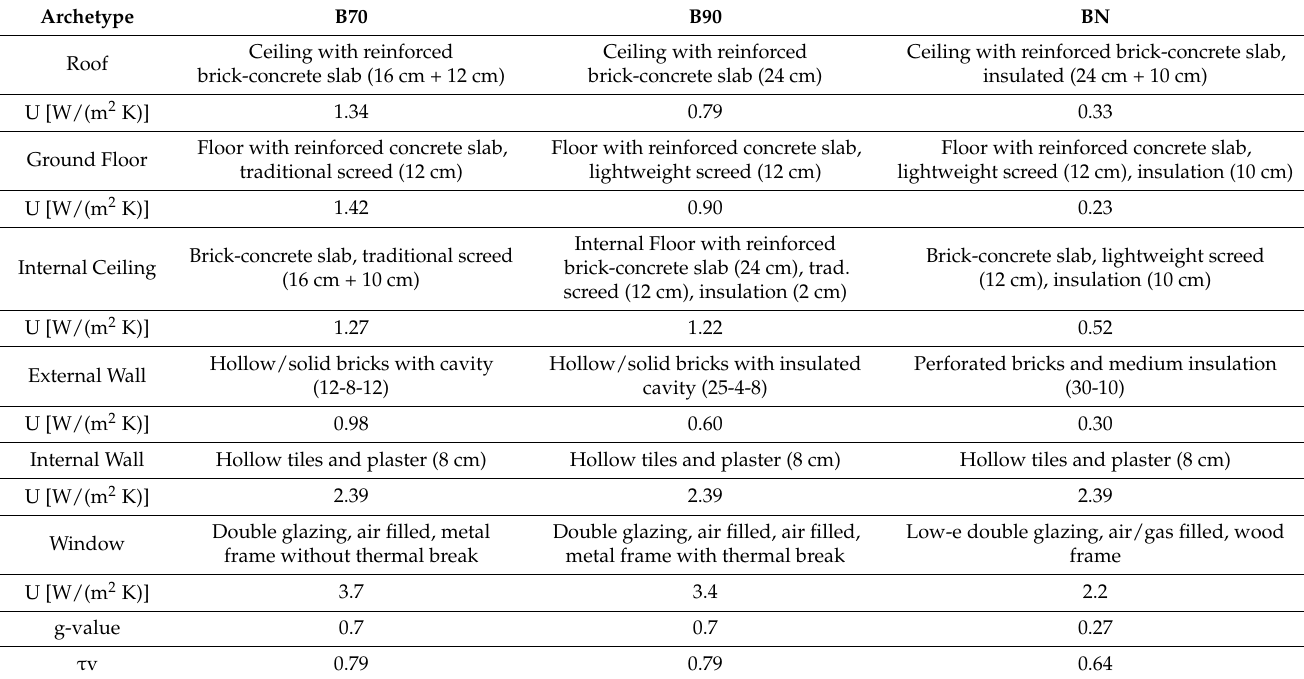
Table 1. Building archetypes from different age classes.